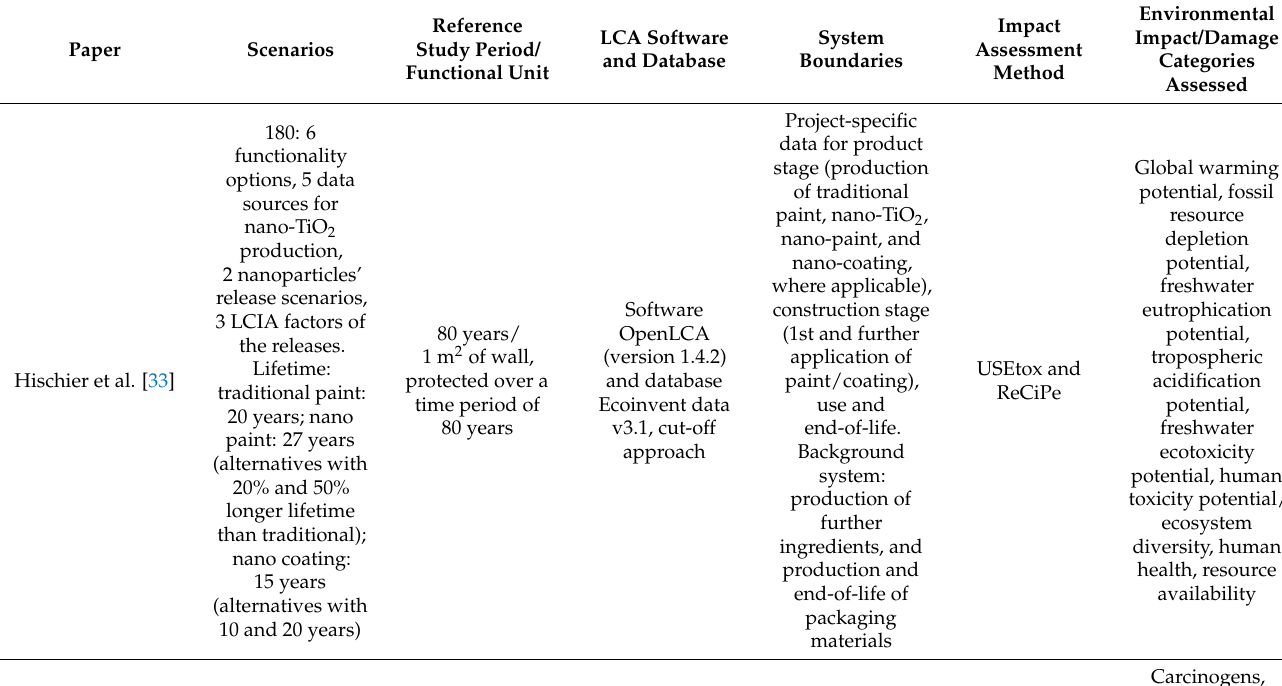
Table 8. Parameters regarding LCA scopes of the studied papers for sustainability